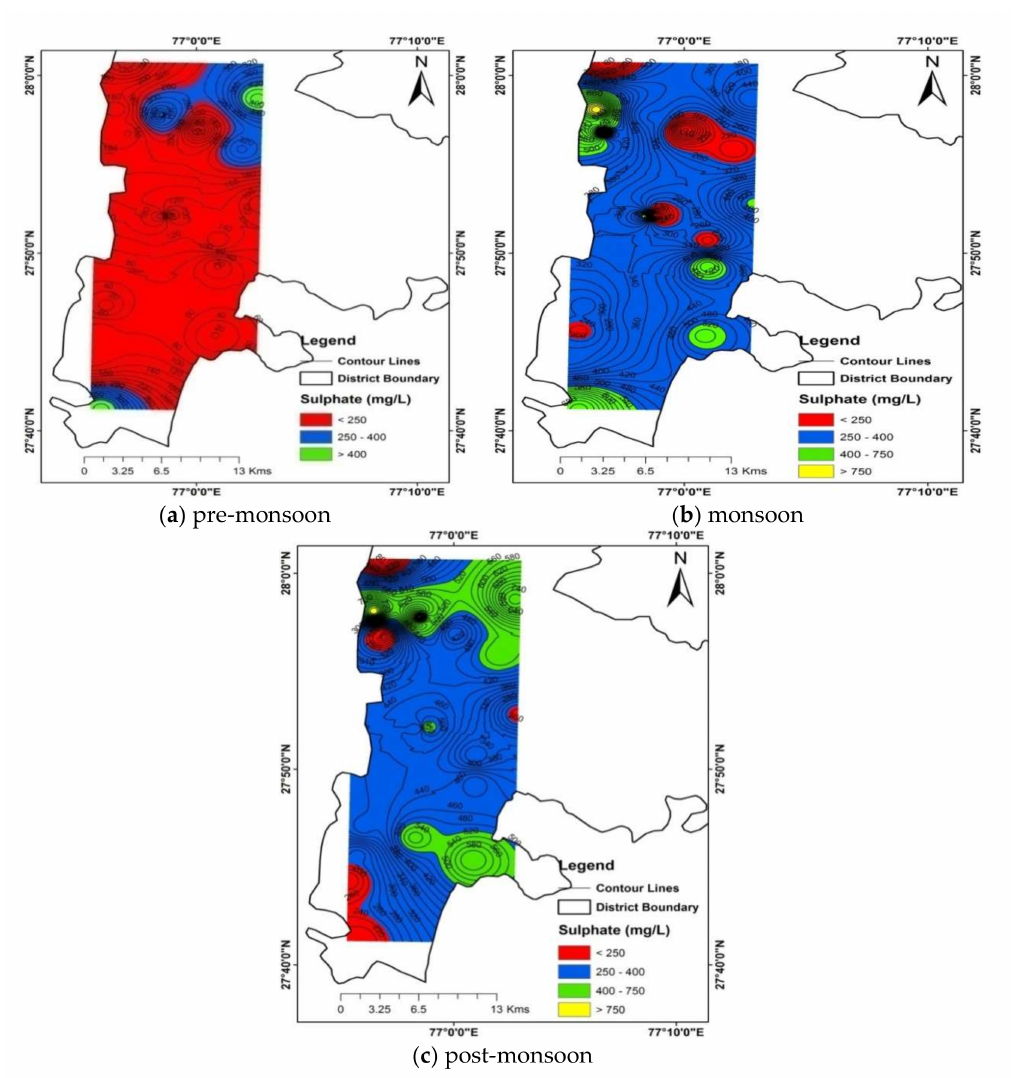
Figure 9. Contour map of sulphate for ( a ) pre-monsoon ( b ) monsoon ( c )